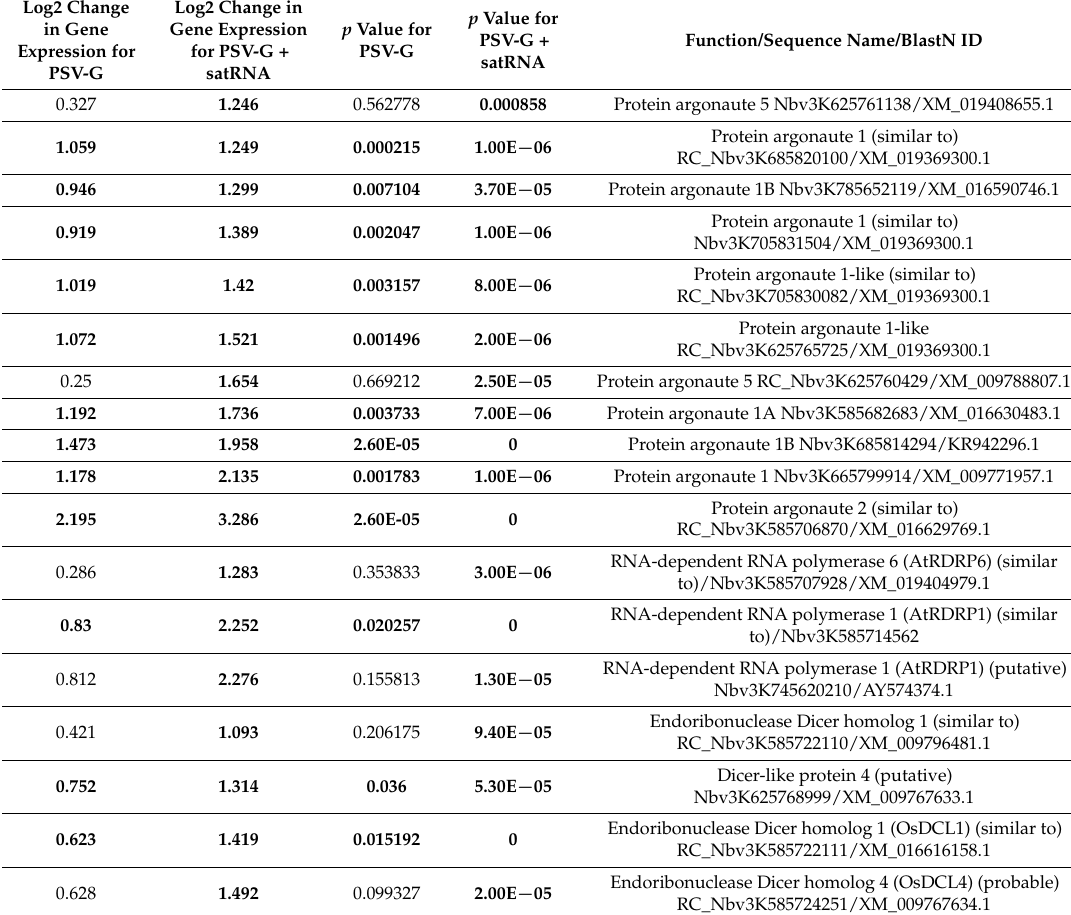
Table 3. Expression levels of genes that encode proteins involved in posttranscriptional gene silencing. Log2 Change Log2 Change in p Value for in Gene Gene Expression Expression for for PSV-G + satRNA PSV-G